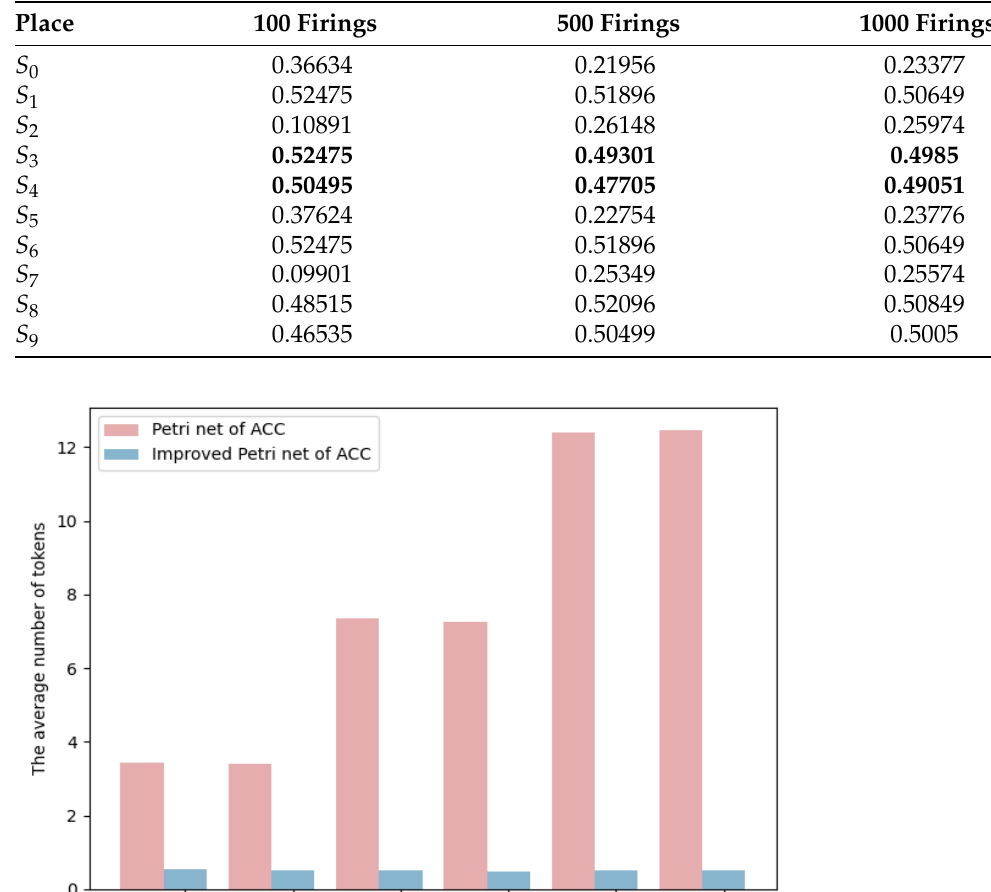
Table 3. The average number of tokens after simulation in improved Petri net of ACC (The Bold indicates comparison with Table 2).